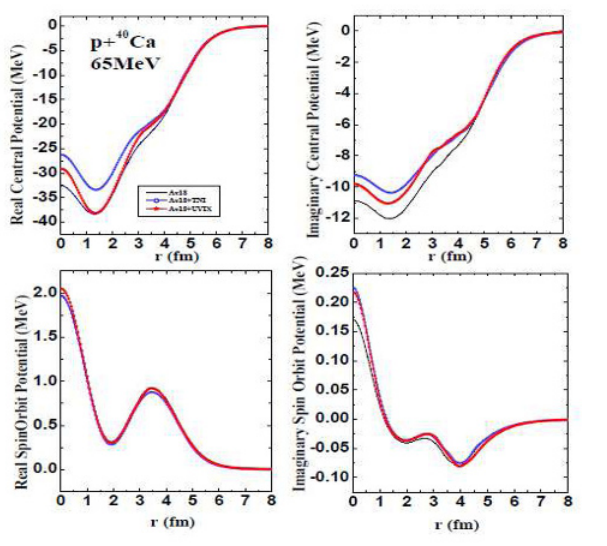
Figure 1 : The calculated central and spin-orbit parts of the optical potential for p - 40 Ca scattering at 65 MeV .